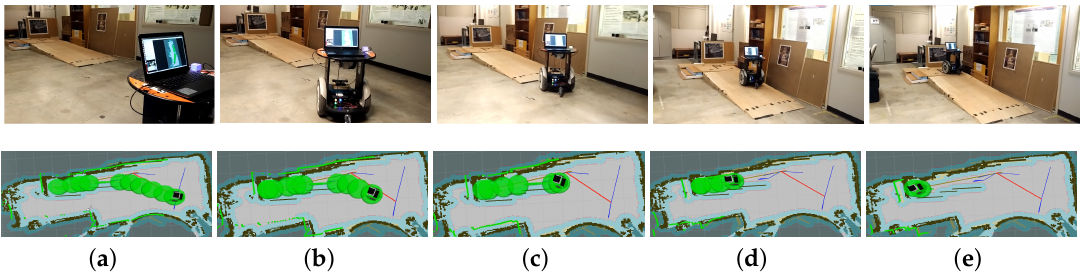
Figure 13. Robot autonomous navigation example in a real environment (Task 3 in Table 3). ( a , b )The robot is approaching the slope; ( c ) the robot is to climb the slope; ( d ) the robot is climbing the slope; ( e ) the robot reaches the target above the ground.